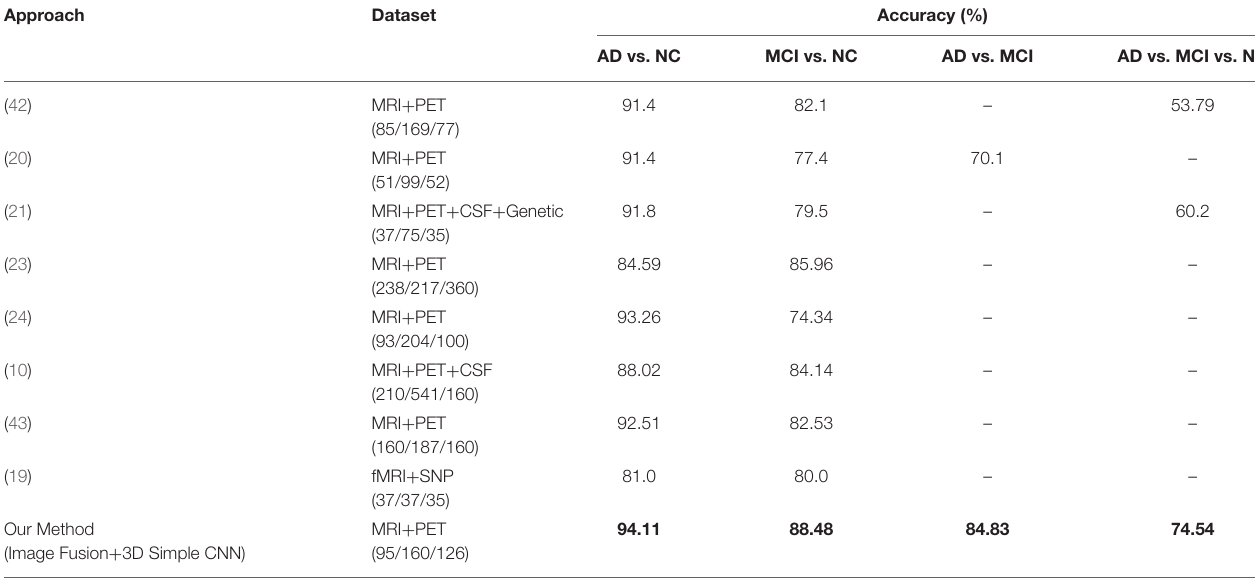
TABLE 6 | Comparative performance of our classifiers vs. competitors. Numbers in parentheses denote the numbers of AD/MCI/NC subjects in the dataset used.